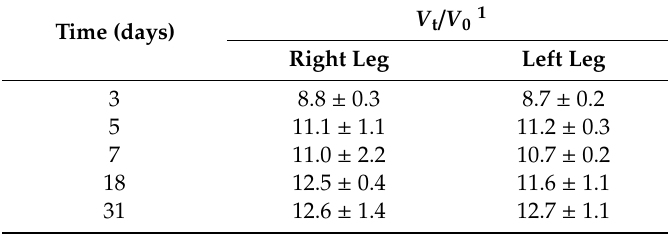
Table 5. The volume ratio ( V t / V 0 ) of polySMA-0.7 expanders removed after certain time of the implantation into rat